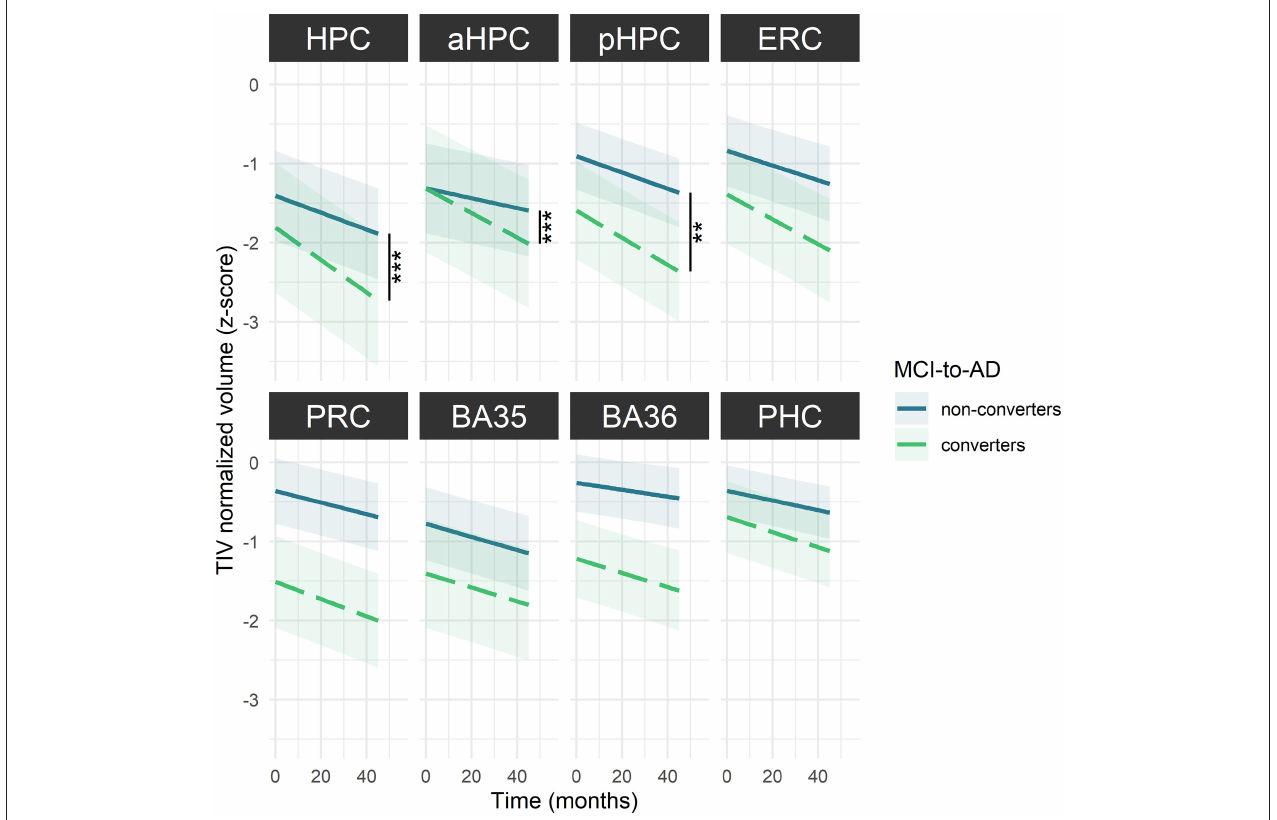
FIGURE 4 | MTL subregions volume decline over time among MCI-to-AD converters and non-converters. The regression line indicates model-derived estimates. The shaded area represents a 95% confidence interval. *** p < 0.001; ** p < 0.01, as results of F-tests after the Holm correction. BA, Brodmann area; ERC, entorhinal cortex; HPC, hippocampus (a, anterior; p, posterior); MCI, mild cognitive impairment; PHC, parahippocampal cortex; PRC, perirhinal cortex. The corresponding statistics are depicted in Supplementary Table 8